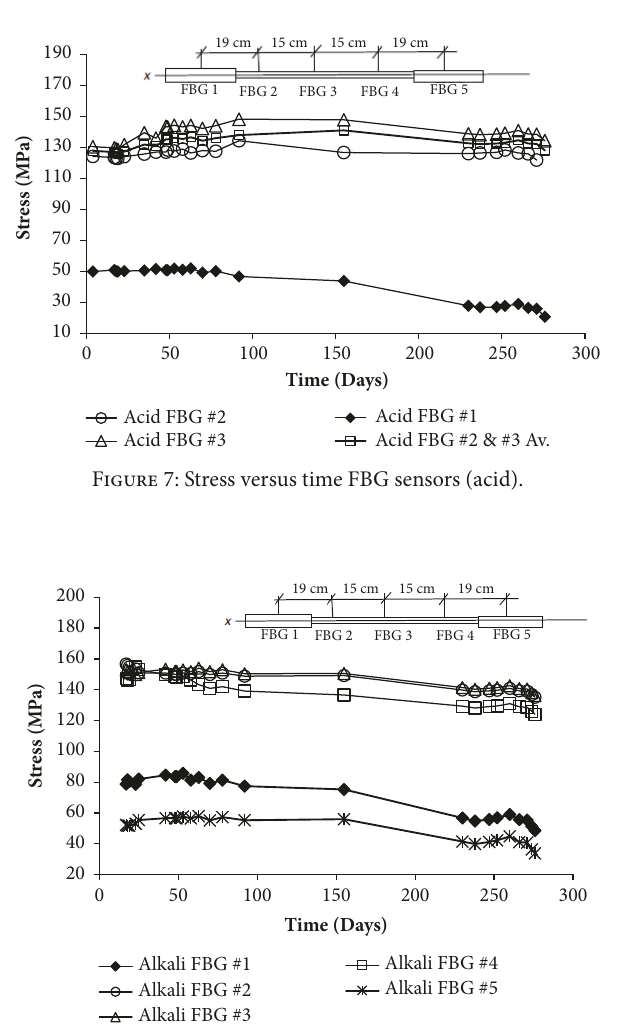
Figure 8: Stress versus time Alkali FBG sensors.